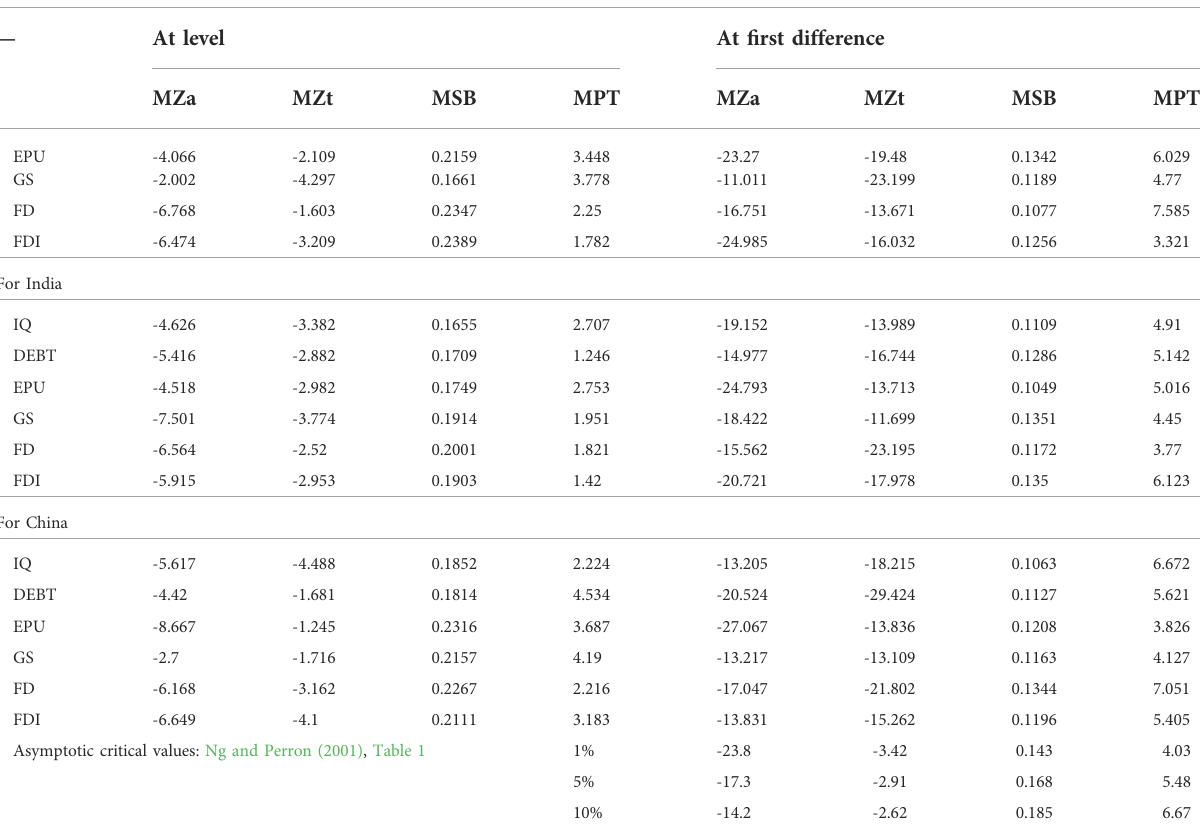
Asymptotic critical values: Ng and Perron (2001), Table